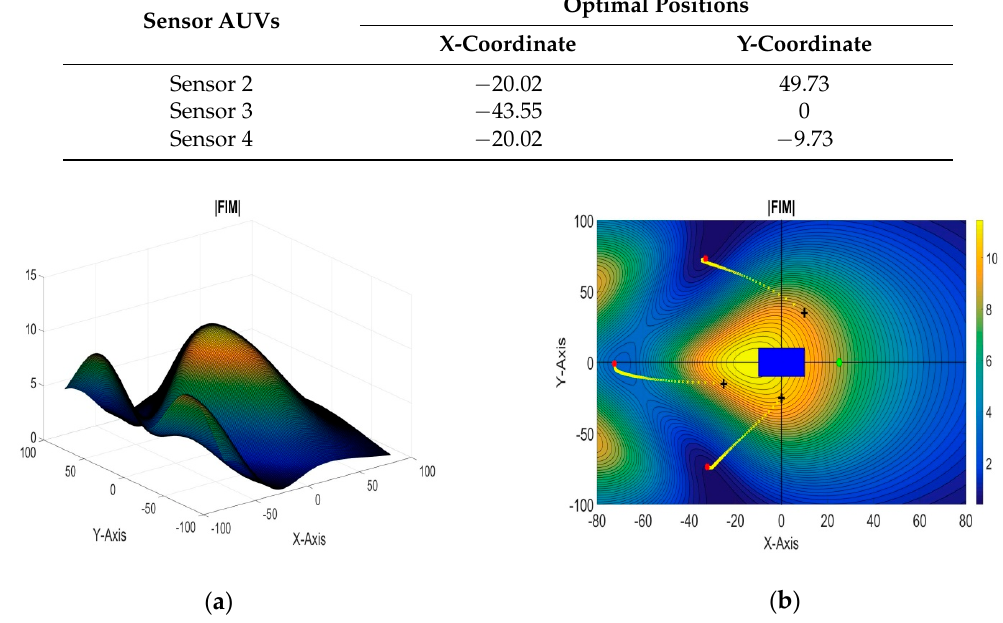
Figure 9. ( a ) 3D plot of the evaluation function (with uncertain target position); ( b ) 2D contour plot of the evaluation function (with uncertain target position).